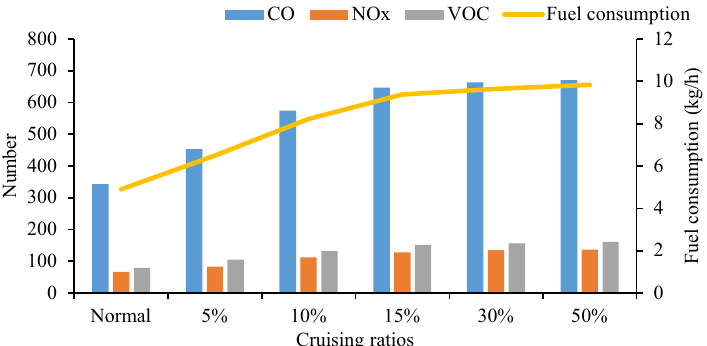
Figure 22. Traffic emissions on the road network.